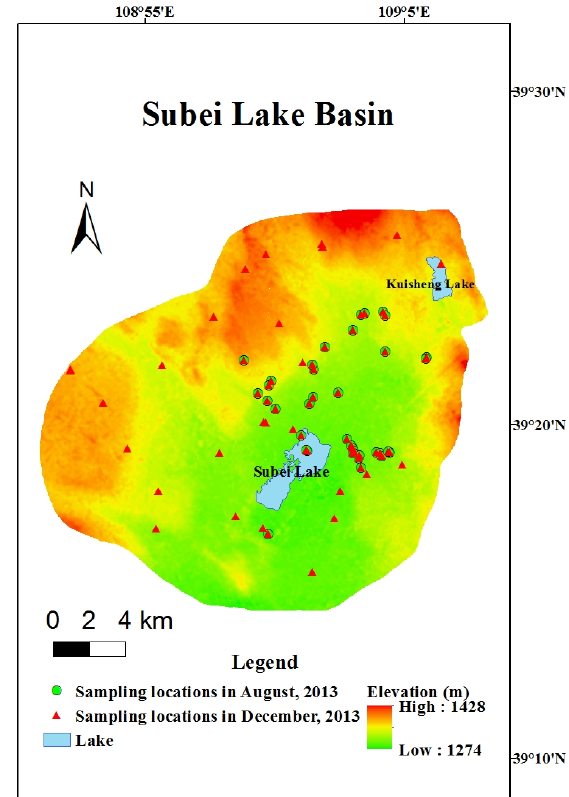
Figure 5. Sampling locations in August and December